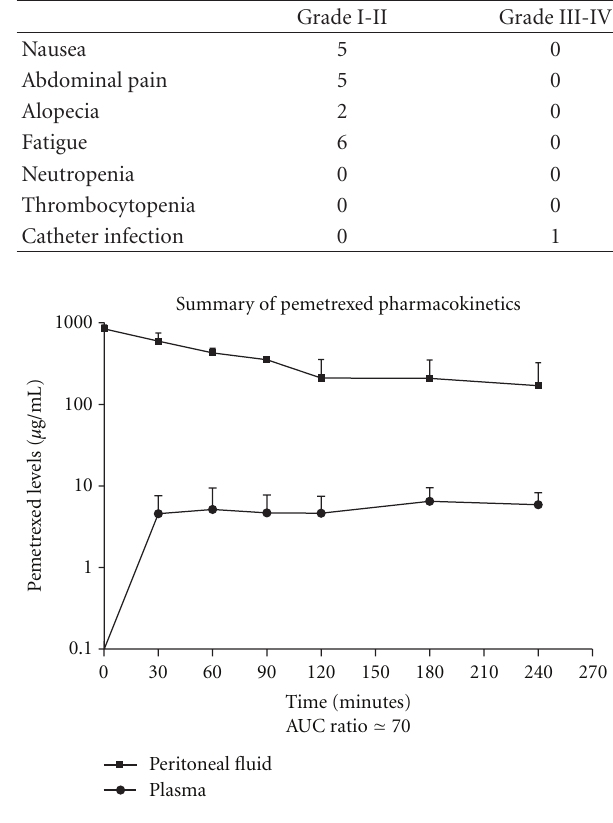
Figure 1: Concentration times time graph of pemetrexed in peritoneal fluid and plasma from four di ff erent pharmacologic studies. The AUC ratio of peritoneal fluid to plasma was 70. Peak plasma concentration was 0.05 (+0.02) µ g/mL at 30